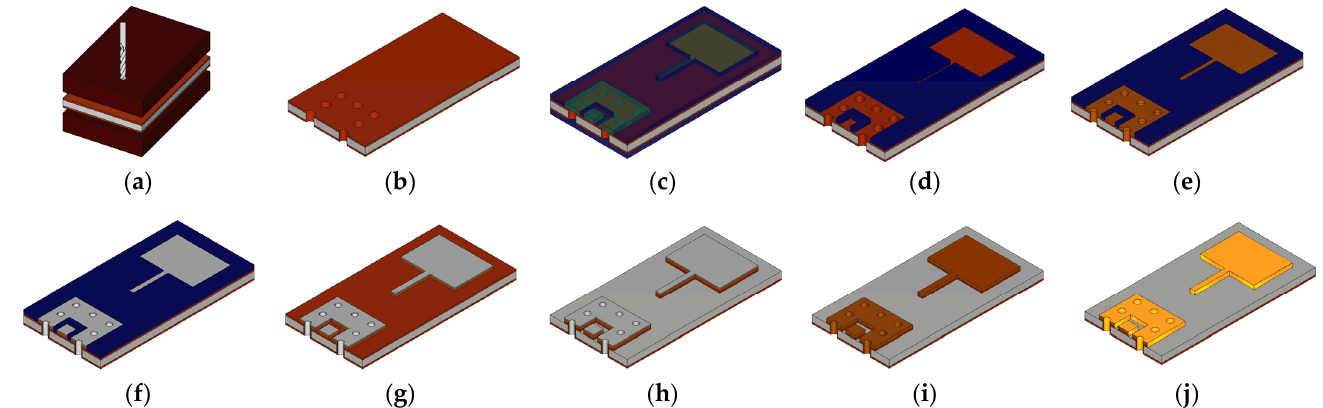
Figure 10. Fabrication stages: ( a ) drilling holes in laminate with phenolic overlays; ( b ) surface activation and chemical application of copper; ( c ) application of the photoresist and exposure (ultraviolet light) of mosaic on the photoresist layer; ( d ) development of the photoresist; ( e ) galvanic application of the copper layer; ( f ) galvanic application of the tin layer; ( g ) photoresist stripping; ( h ) copper etching; ( i ) tin stripping; ( j ) ENIG layer application.